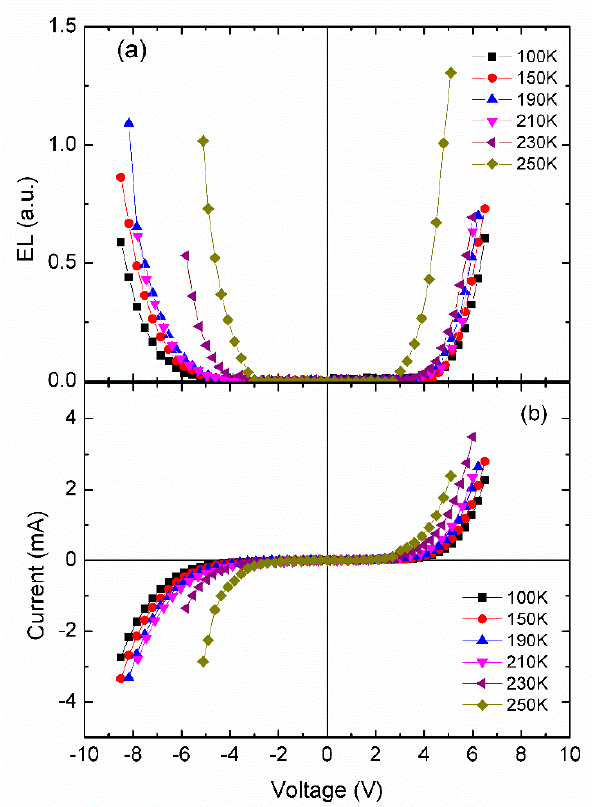
Figure 4. ( a ) The EL-V curves of LEC sample at di ff erent temperatures (from 250 K to 100 K); ( b ) The I-V curves of LEC sample at di ff erent temperatures (from 250 K to 100 K).